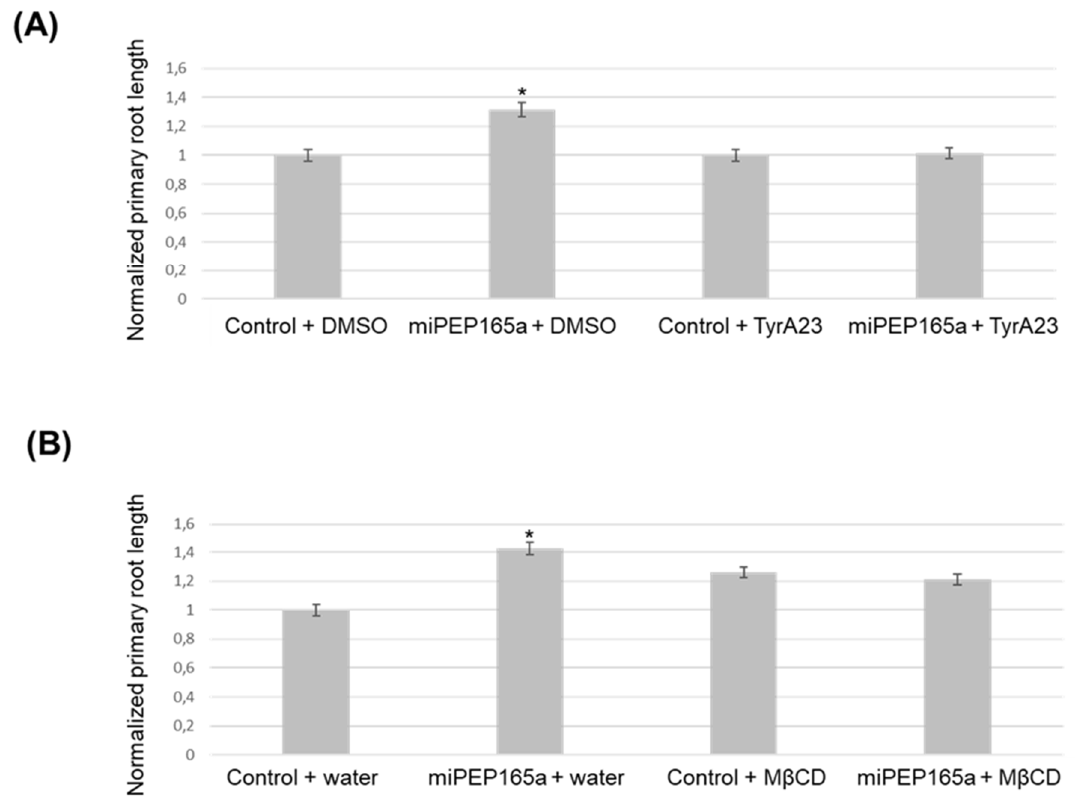
Figure 8. Disruption of endocytic pathways prevents miPEP165a-induced root growth. Normalized primary root growth analysis after treatment with miPEP165a and TyrA23 ( A ) or miPEP165a and M β CD ( B ). Three biological replicates were performed by using at least 100 seedlings for each condition and root lengths were statistically analyzed using a t -test ( p < 0.01, *). The data represent the mean value ± SEM. Water was used as a control for the miPEP165a treatment.